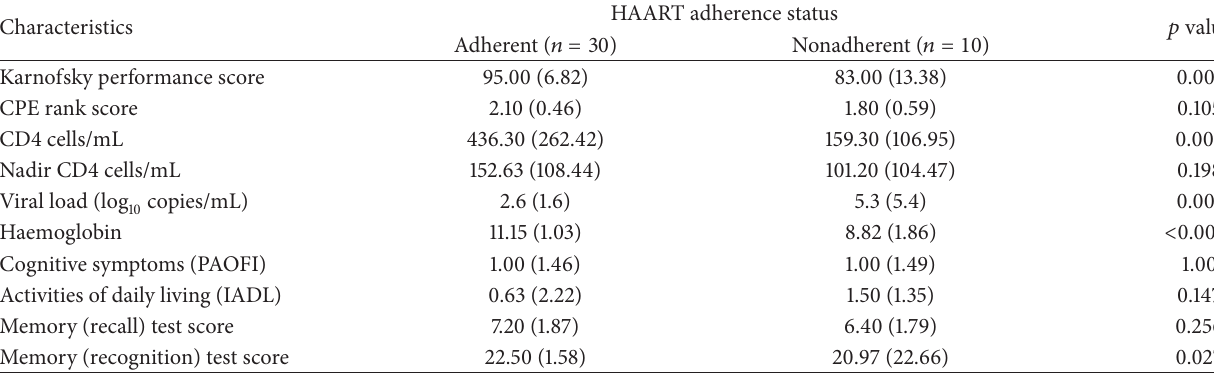
Table 5: Characteristics of HIV-positive individuals based on adherence to